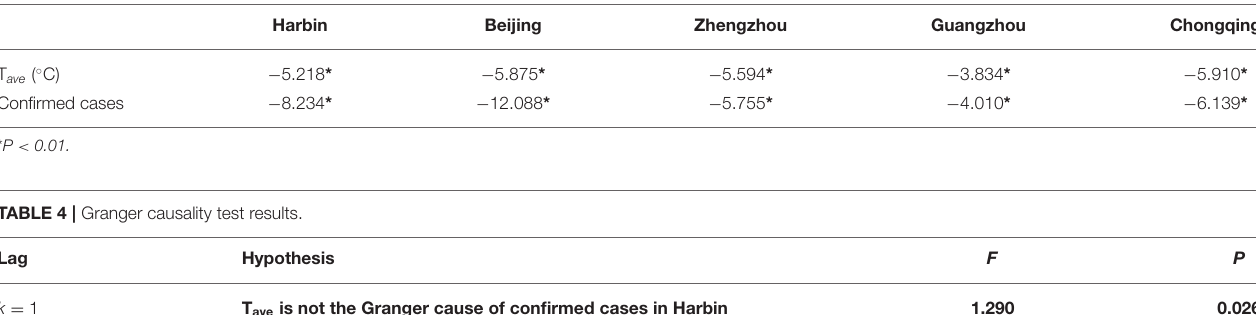
TABLE 3 | Augmented Dickey-Fuller test results for daily average air temperature (T ave ) and confirmed cases in 5 cities.